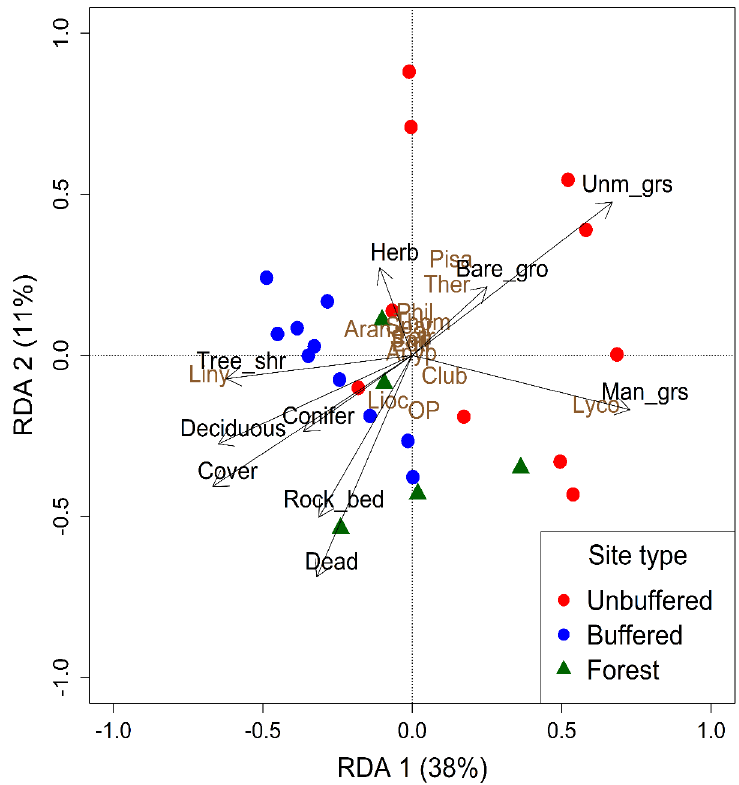
Figure 4. Redundancy analysis (RDA) triplot showing the effect of habitat types on the spider communities. Spider family abbreviations are overlaid in brown text (see Figure 3). Habitat types: